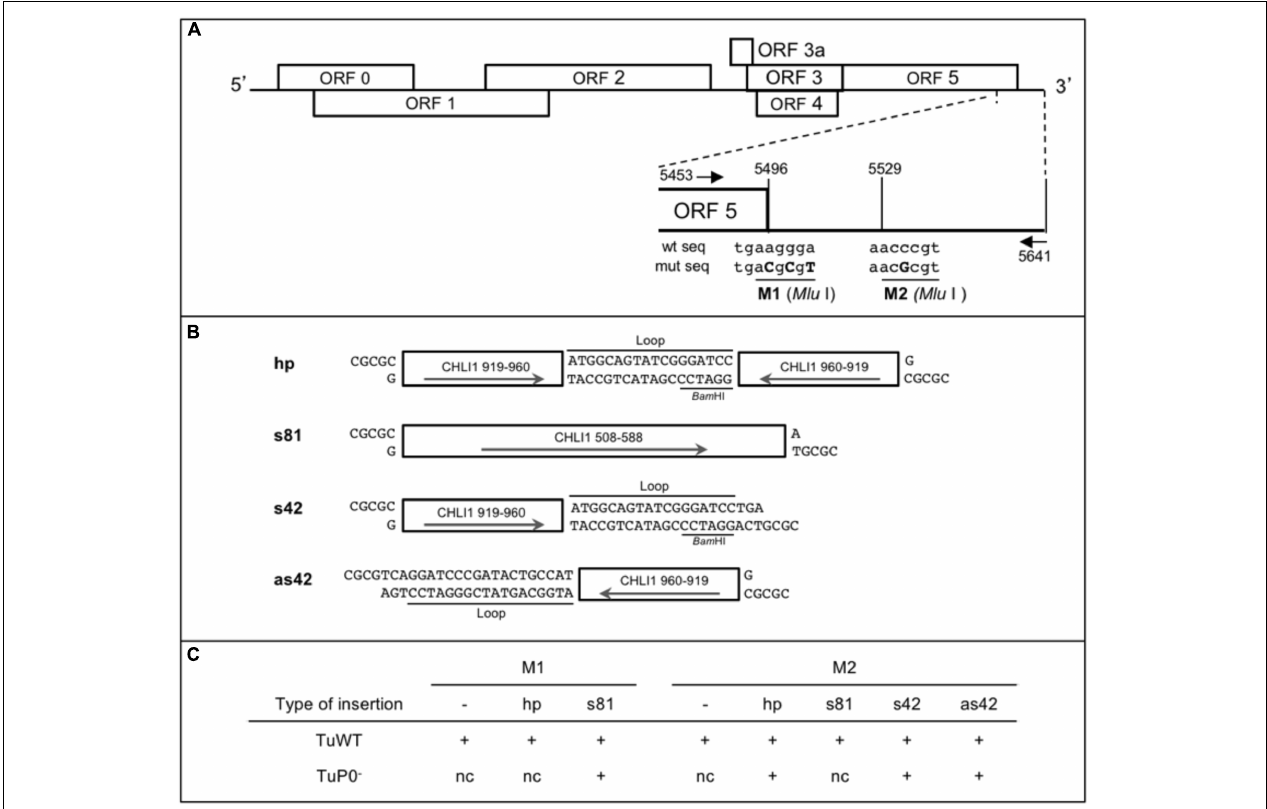
FIGURE 1 | Design of CHLI1 constructs and their sequences introduced in TuYV recombinant viruses used as VIGS vectors. (A) Schematic representation of the TuYV genome and position of the two Mlu I restriction sites (M1 and M2) in the 3 (cid:48) end of the TuYV genome. The mutated nucleotides introduced in the virus genome are shown in capital letters. The arrows locate the position of the primers (Tu-5453-Fw and Tu-5641-Rev) used to perform the PCR reactions to analyze the viral progeny in infected plants ( Supplementary Table S1 ). (B) Description of the CHLI1 fragments inserted into one of the Mlu I sites to produce the recombinant viruses. hp, hairpin sequence; s81, sense sequence of 81 nucleotides (nts); s42, sense sequence of 42 nts; as42, antisense sequence of the same 42 nts. s42 and as42 contain in addition a 18 nts heterologous sequence annotated “Loop” that contributed to the construction of the hp clone. Arrows indicate the orientation of the inserts. All DNA fragments have Mlu I compatible cohesive ends. Position of the Bam HI site in the loop sequence is indicated. (C) Overview of the viral constructs. “+” indicates the recombinant viruses that were generated. M1 and M2 refer to the restriction sites used to introduce the different CHLI1 fragments. “–” refers to the viral mutants containing only the above indicated Mlu I restriction site with no additional sequence. TuWT and TuP0 - are the viral backbones in which the different fragments were inserted. nc, clone not constructed.